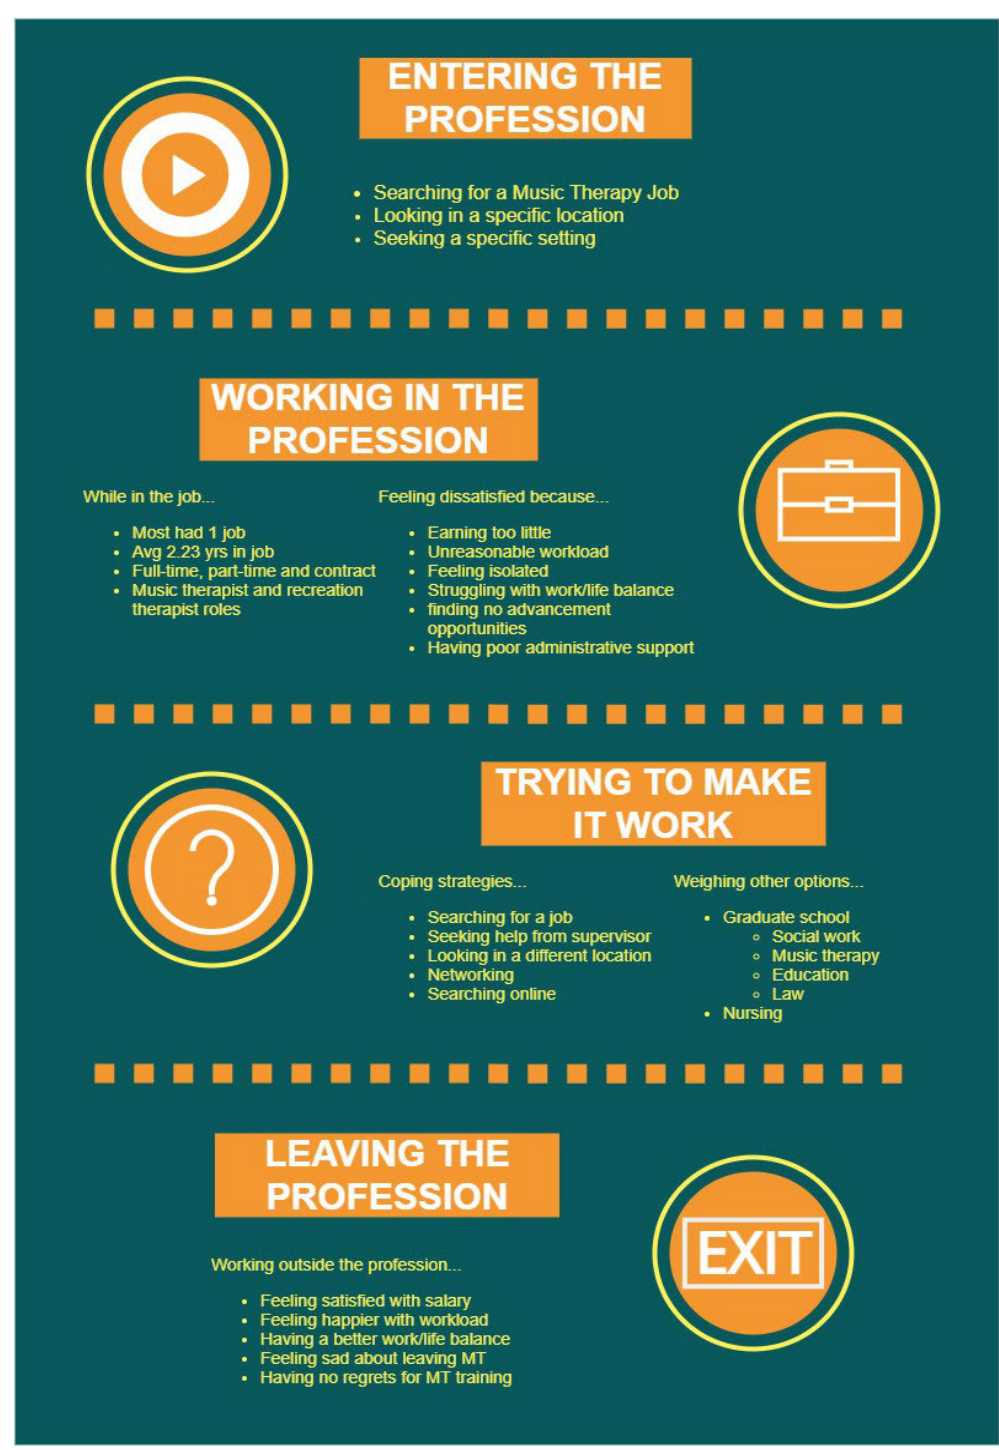
Figure 2. Participant